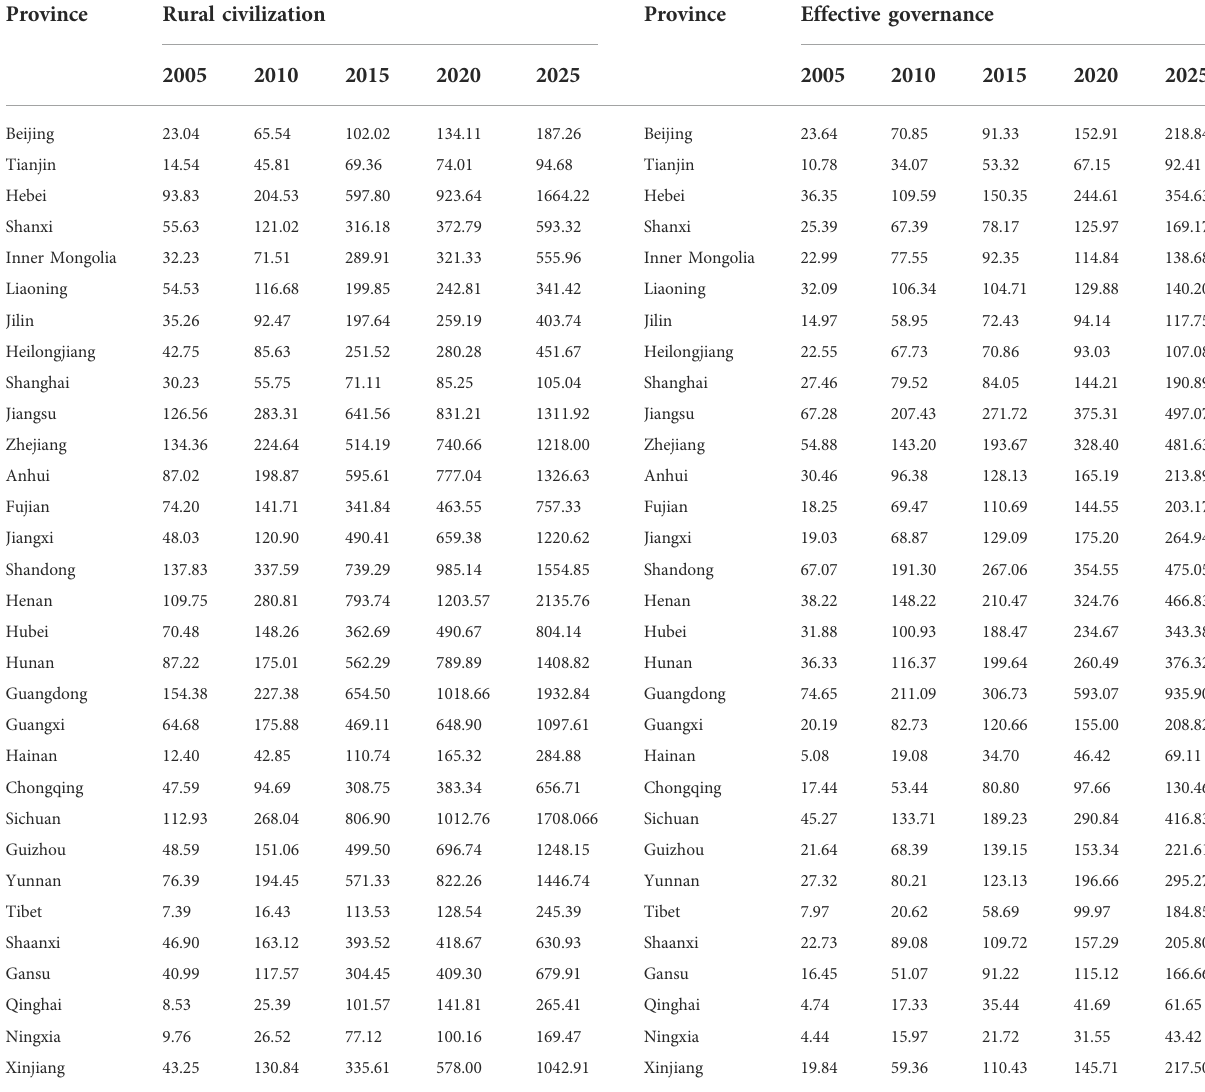
TABLE 5 31PLAD Rural Civilization-Effective Financial Expenditure for Governance (Unit: 100 million). Province Rural